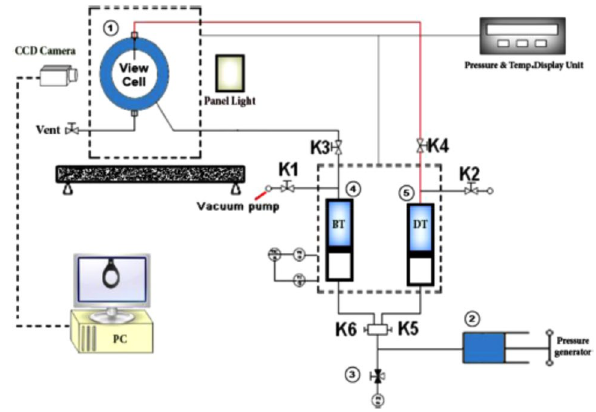
Fig. 1 The used IFT measurement Apparatus (1, view cell; 2, pres‑ sure generator; 3, pressure manometer; 4, bulk tank; 5, drop tank) (Zolghadr et al.